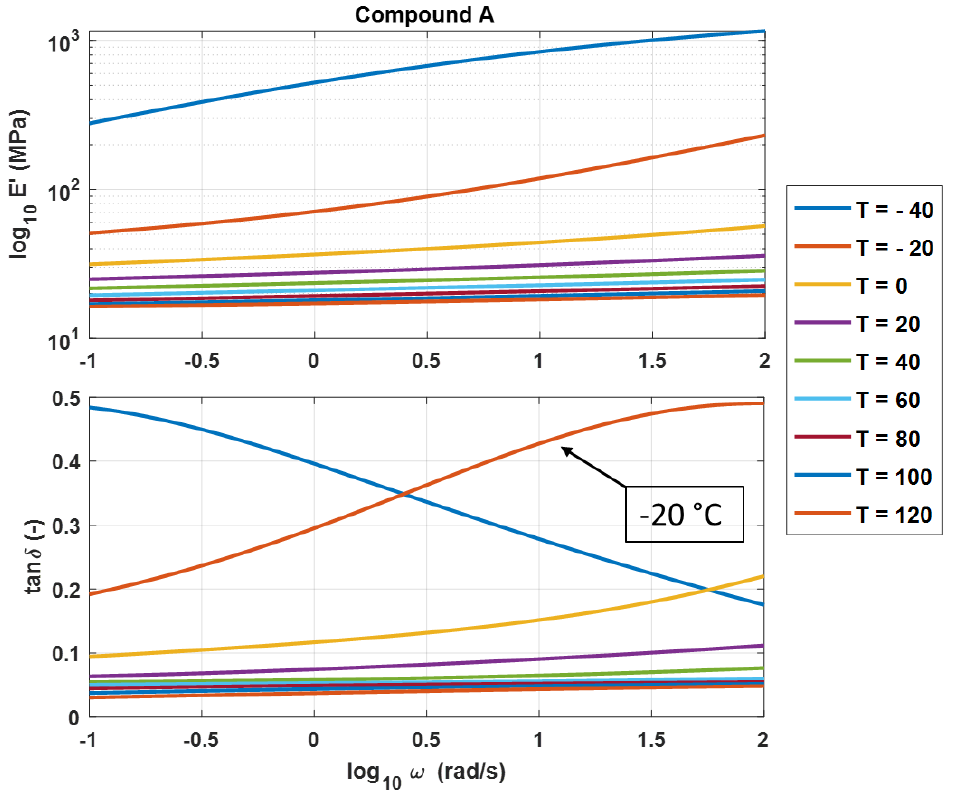
Figure 6. Experimental DMA isothermal curves.